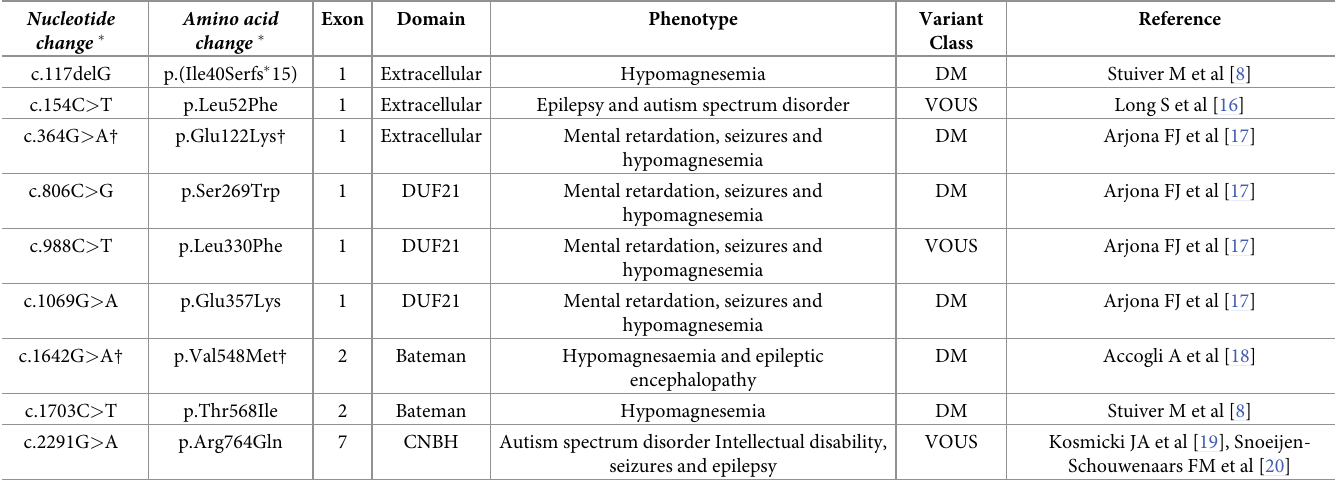
Table 1. CNNM2 variants previously identified in patients.